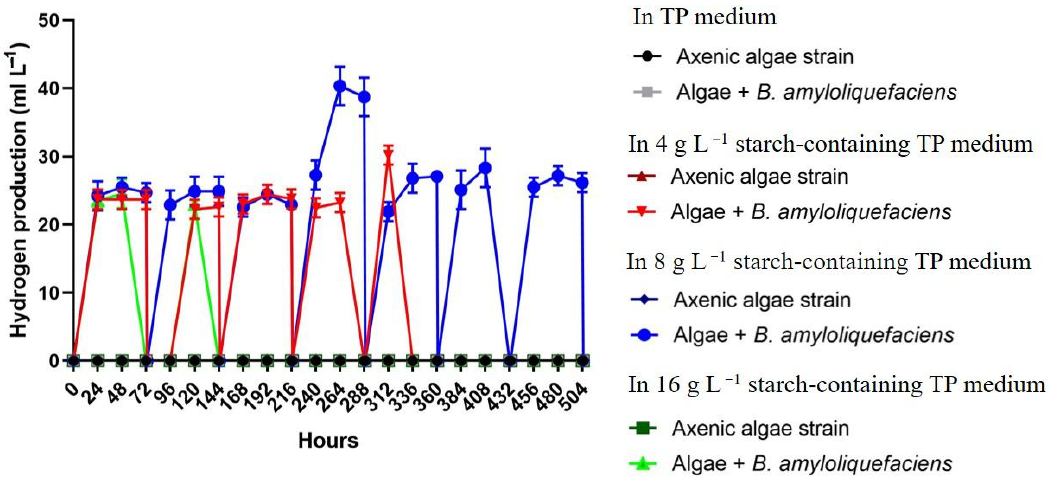
Figure 5. Continuous hydrogen production of Chlorella sp. MACC-360 in acetate-free TP medium supplemented with elevated amount of bacterial partner (the initial bacterial OD 600 of 0.175). Hy- drogen was measured in the headspace at every 24 h. Bottles were aerated for 5 min after hydrogen measurement at every 72 h. Error bars are standard deviations based on three replicates.